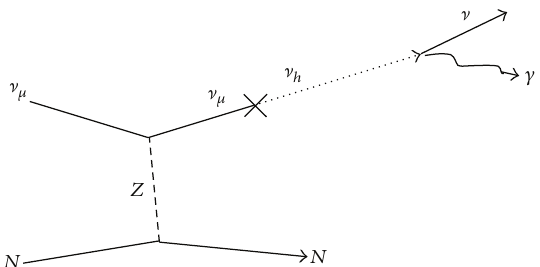
Figure 10: The concept of a heavy neutrino decay signal in the Mini- BooNE detector [73]. The mixing of a neutrino with a hypothetical heavy neutrino and its short life time allows for it to decay in the MiniBooNE detector to leave a photon